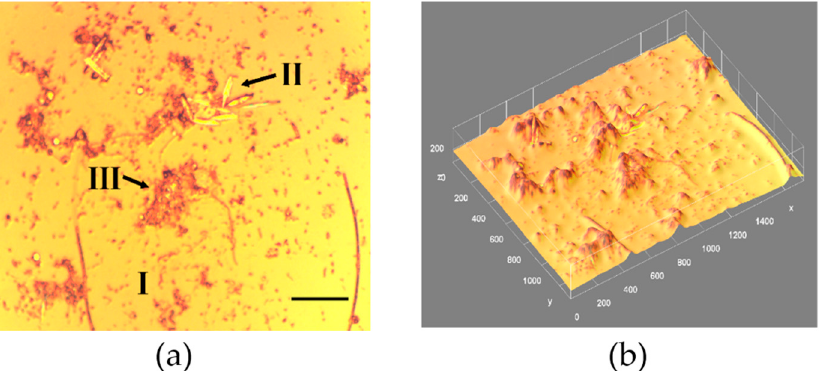
Figure 1. ( a ) A microscopic projection image of a marine biofilm grown on glass slides (14-day old) in Baltic Sea coastal waters (Gulf of Gda´nsk, Poland) collected in August 2018; covered area 460 × 570 µ m. Black arrows indicate the different reflective structures containing bare glass substratum (I), silica frustules of diatoms (II), and amorphous material (III). Marker bar is 10 µ m; distance scale 36 pixels = 10 µ m. ( b ) 3D reconstructed image from ( a ); morphological film structure parameters: total surface coverage f = 18.3%, mean thickness = 43 µ m, roughness fluctuation coefficient = 0.162, biovolume = 35,800 μ m 3 , fractal dimension = 1.64, Hopkin’s aggregation index = 2.79, AC = 0.47, diatom abundance = 6.3 × 10 4 ind. cm − 2 .